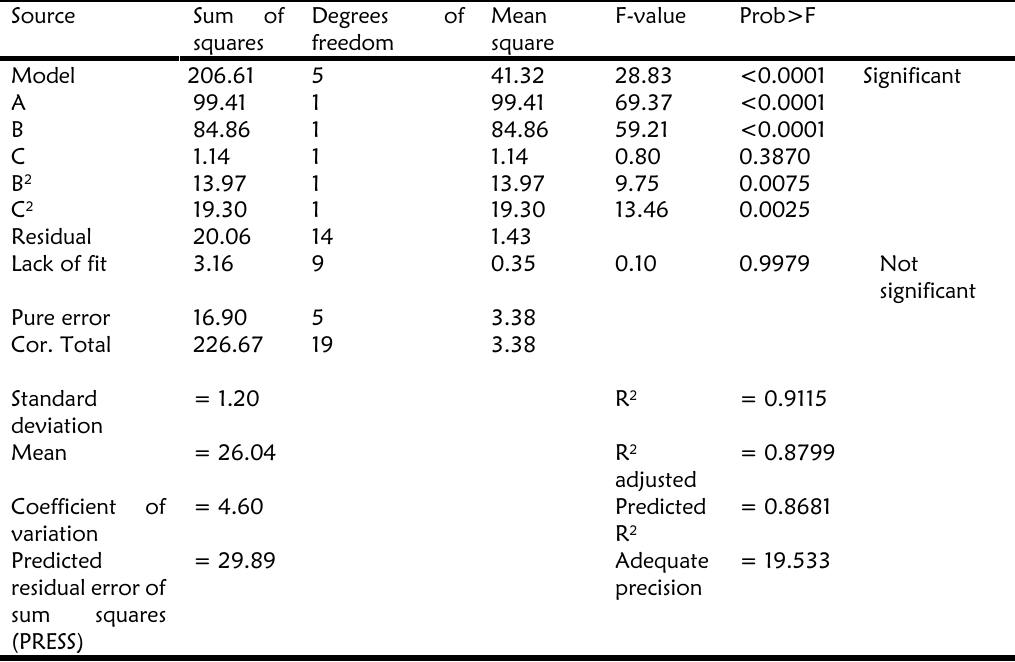
Table 6: ANOVA for recast layer (after